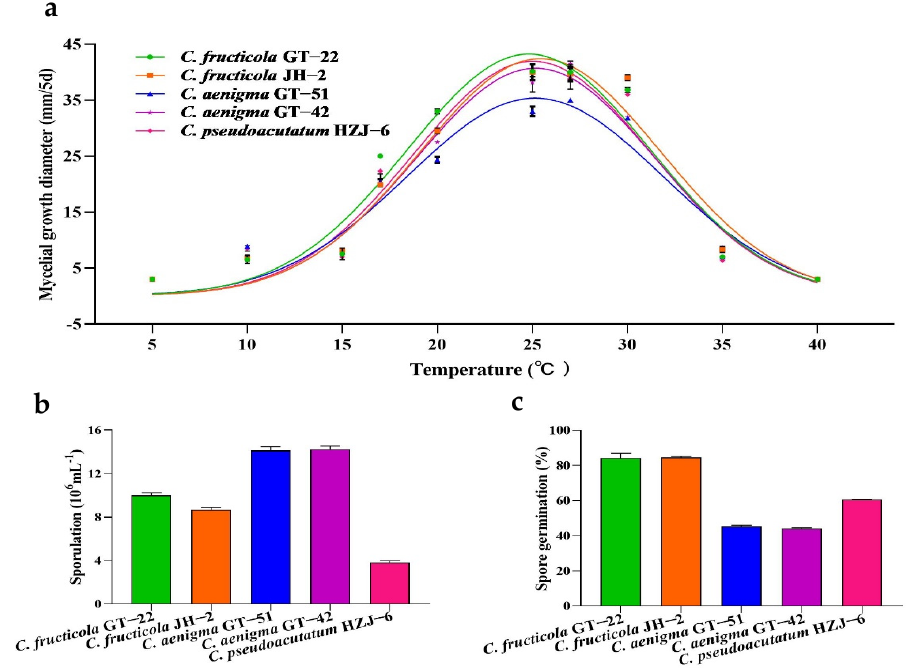
Figure 7. Biological characteristics of Colletotrichum species. ( a ) Colony diameter of Colletotrichum species at different temperatures. The colony diameter of each Colletotrichum isolate is the mean ± standard error of three independent experiments. Different symbols represent the mean colony diameter of different species at the tested temperatures. Gaussian process regression was used to estimate the optimum temperature for mycelial growth. Comparison of sporulation ( b ) and spore germination ( c ) of Colletotrichum species.